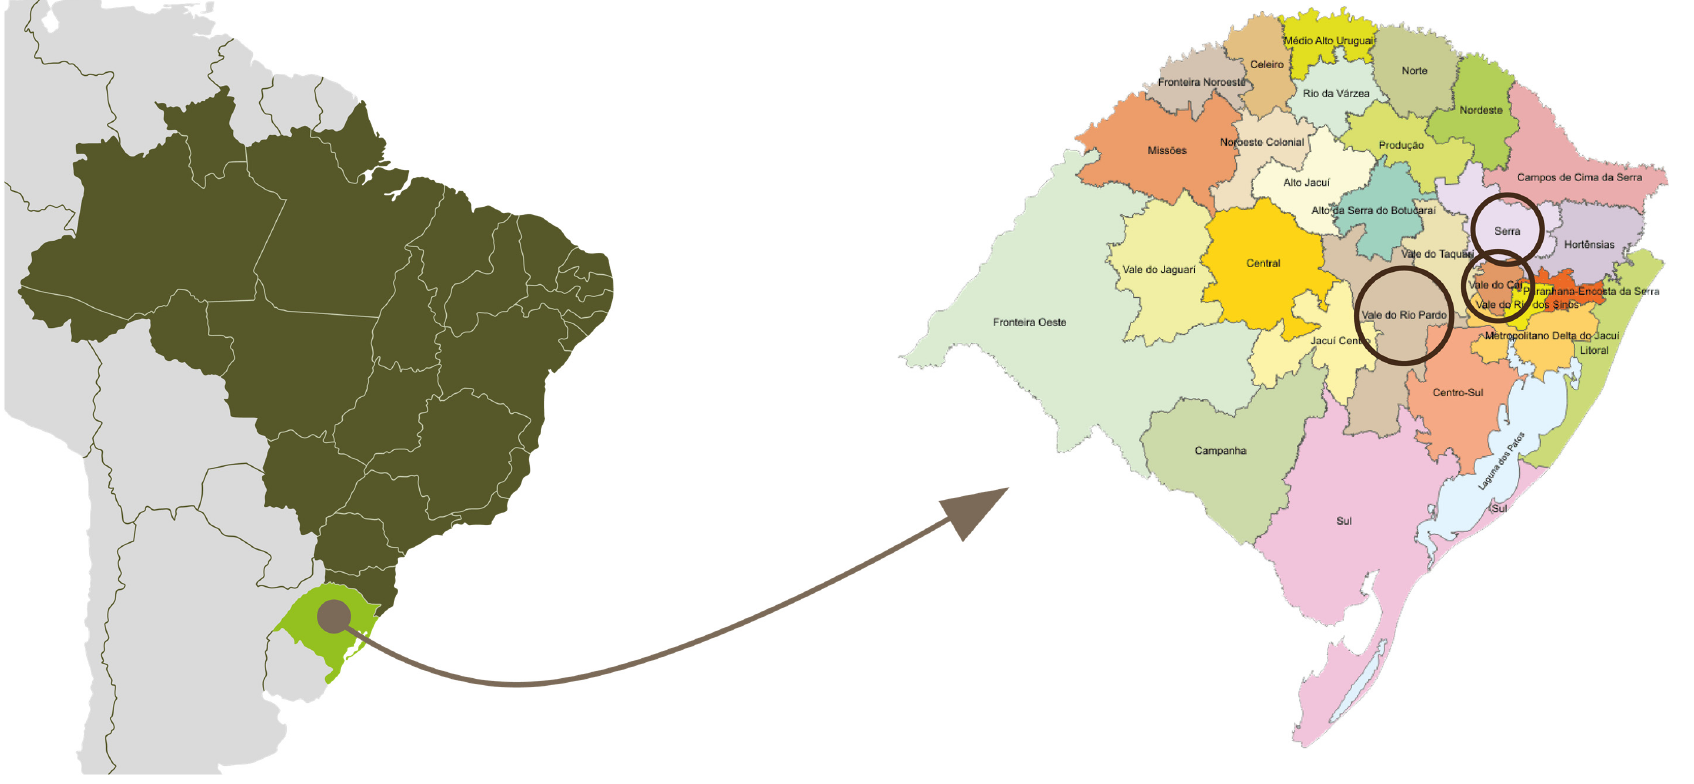
Figure 1. Rio Grande do Sul in Brazil and the location of the study areas.